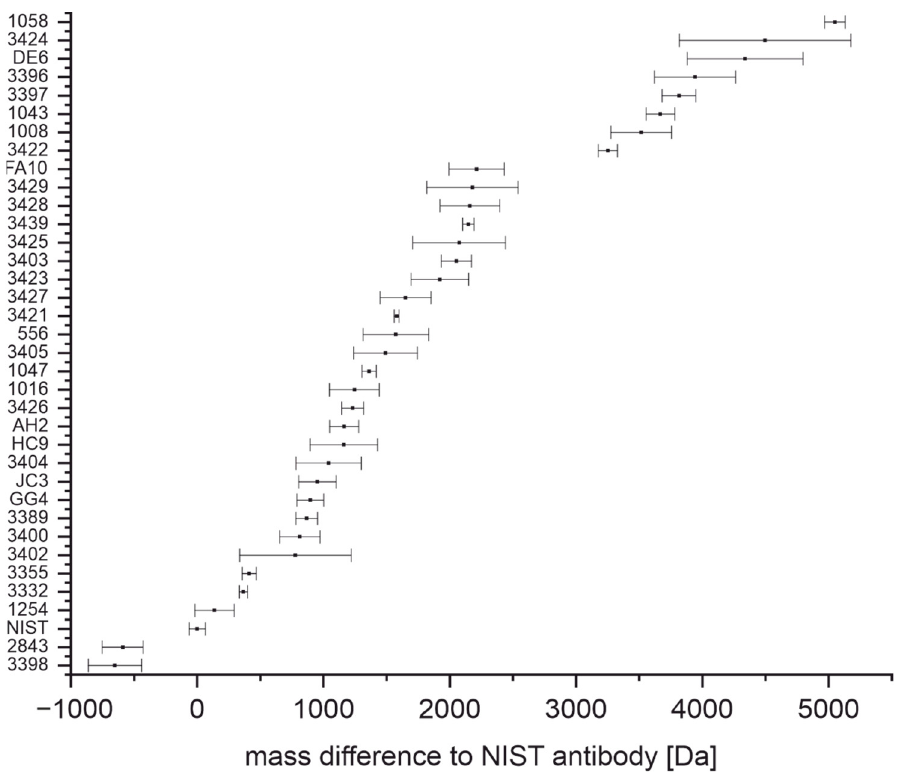
Figure 2. Intact masses of anti-SARS-CoV-2 antibodies relative to NIST-mAb 8671 given by a confi- dence level of 95%.